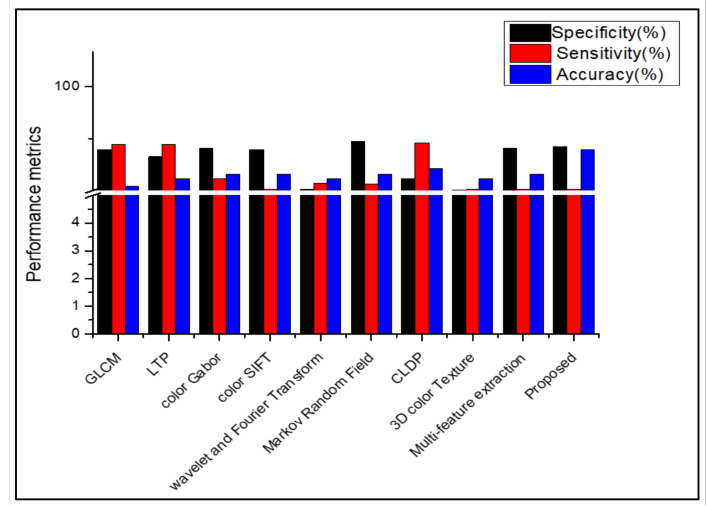
Figure 13. Comparison of performance using various features in